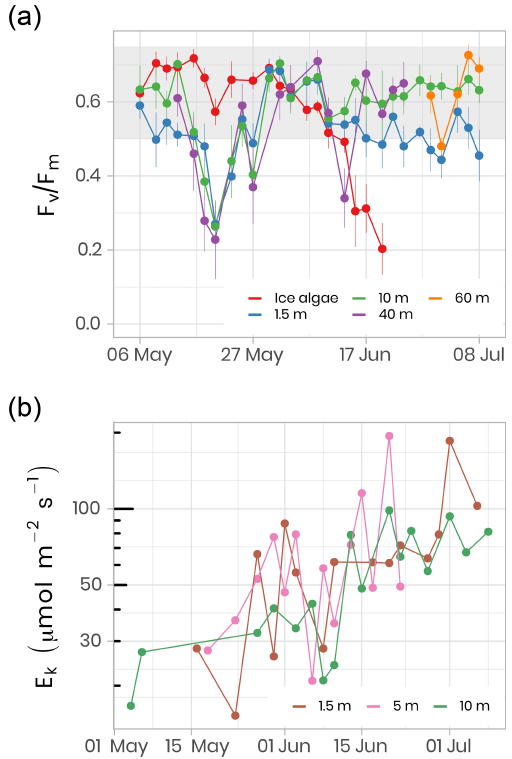
Figure 13. (a) Temporal evolution of F v /F m for ice (lastcm) and water underneath the ice (depths 1.5, 10, 40m) samples for the ice camp 2016 between 6 May and 8 July. F v /F m monitoring on ice samples stopped on 20 June because the chl a fluorescence sig- nal was not reliable anymore. F v /F m monitoring on 40 and 60m depth samples was limited between 13 May and 24 June and be- tween 29 June and 8 July, respectively. The gray shaded area rep- resents the range at which the algae are optimally growing. (b) The light saturation parameter, E k , an index of photo-adaptation of the phytoplankton community, was measured at 1.5, 5 and 10m depth. Note the log scale on the y